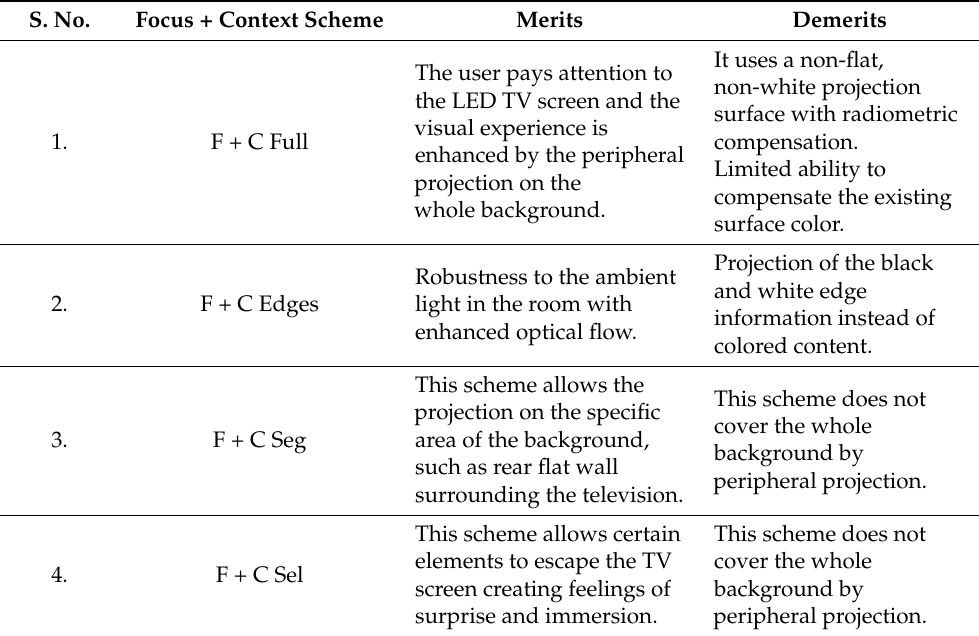
Table 1. Merits and demerits of extended vision design schemes [1]. S.